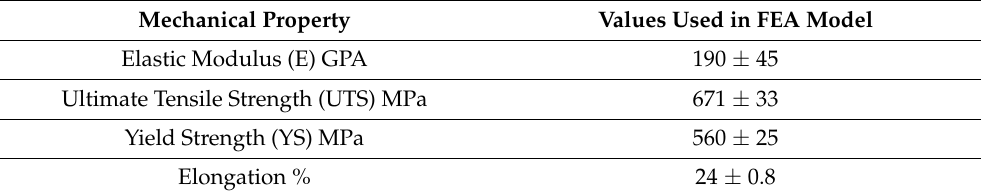
Table 1. Mechanical properties of 3D-printed SS316L [23].